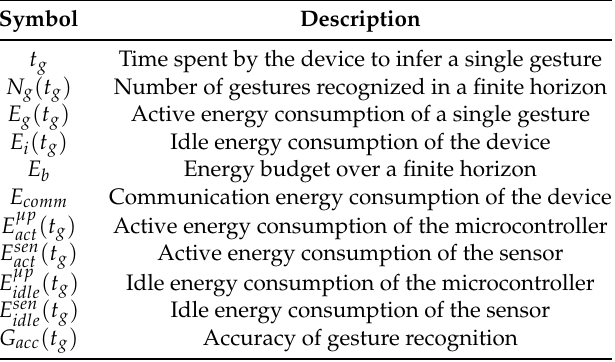
Figure 2. Gesture recognition prototype. MPPT: maximum power point tracking; MPU: motion processing unit; PV: photovoltaic. Table 1. The major